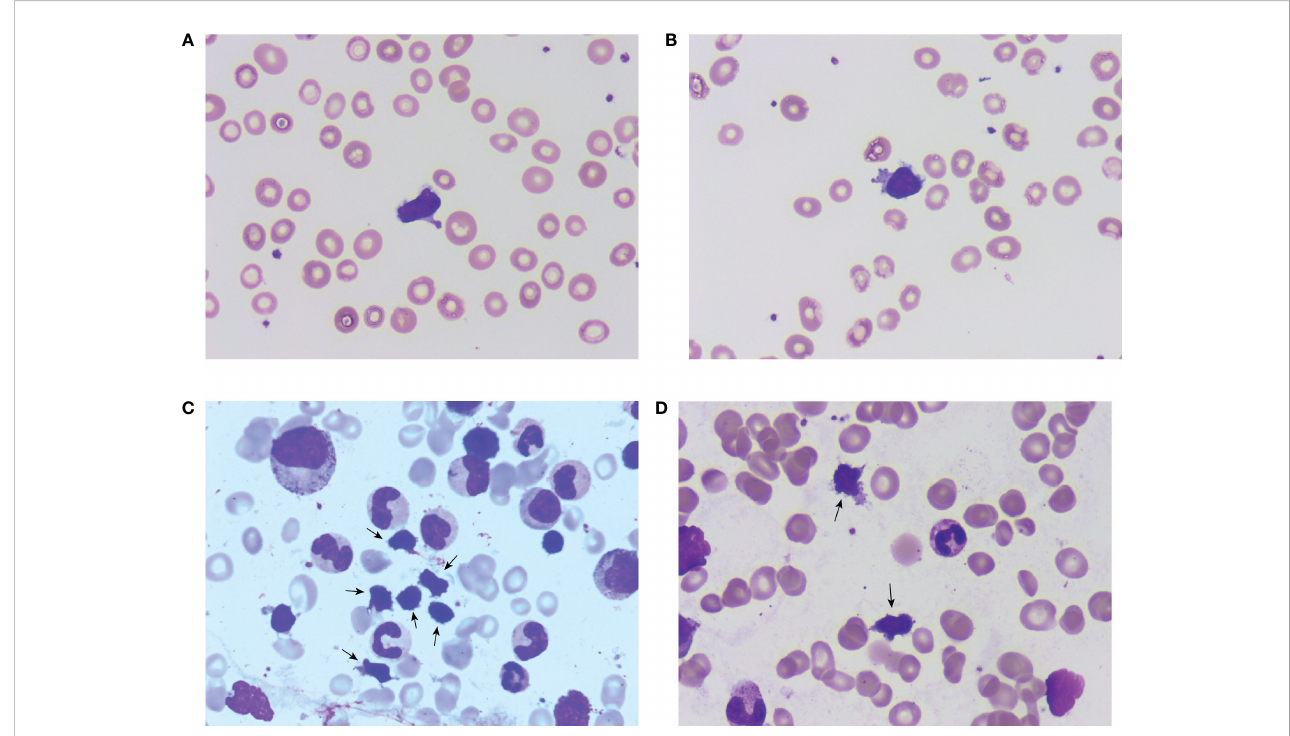
FIGURE 1 Microscopic morphology of the clonal gd T cell subtype. (A, B) show single cells found in a peripheral blood smear and show clear morphological characteristics; (C, D) are clustered cells found in the bone marrow aspirate smear with clear cytoplasmic protrusions.